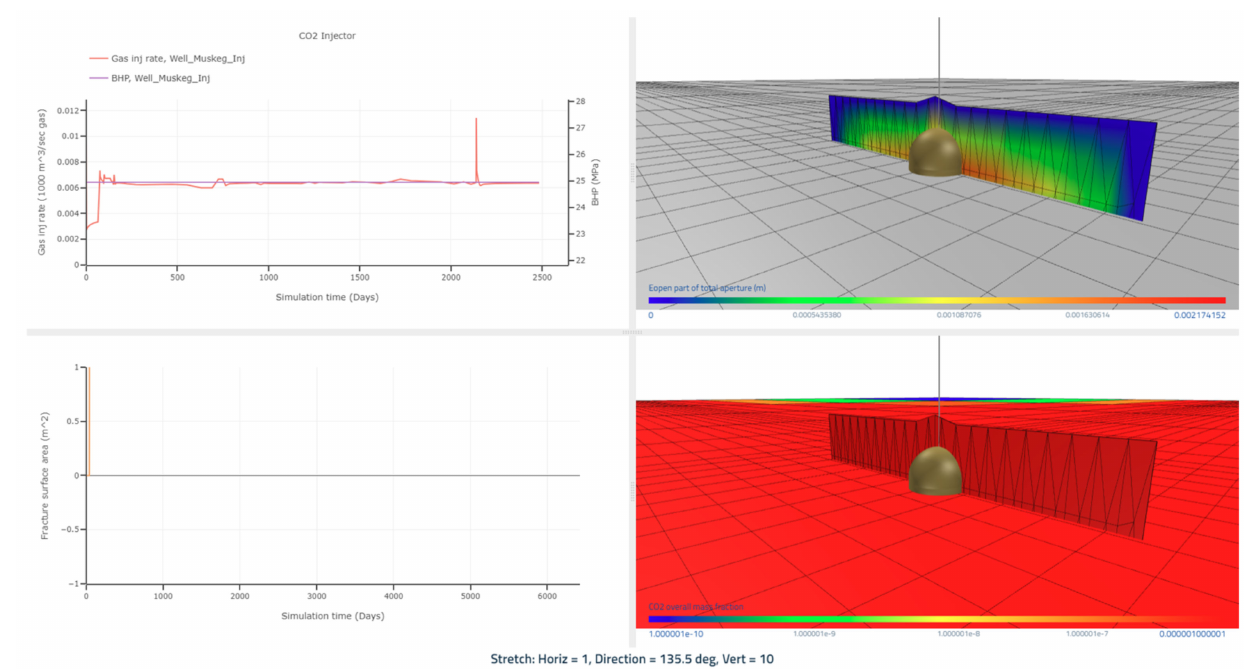
Figure 4. Example of the ResFrac™ model output for a CO 2 injector simulation in the Muskeg Formation conducted under an injection pressure = 1.1 × σ hmin . Upper right: horizontal section across the center of the matrix region and perforations showing fracture element (blue rectangle) and fracture aperture generated. Bottom right: horizontal section across the center of the matrix region and perforations showing CO 2 mass fraction distribution in the fracture element generated and the model domain. Upper left: CO 2 injection rate and bottomhole pressure. Note instability (fluctuations) in CO 2 injection rate. Lower left: fracture surface area created over injection lifecycle. Note fracture surface area generated is non-zero.